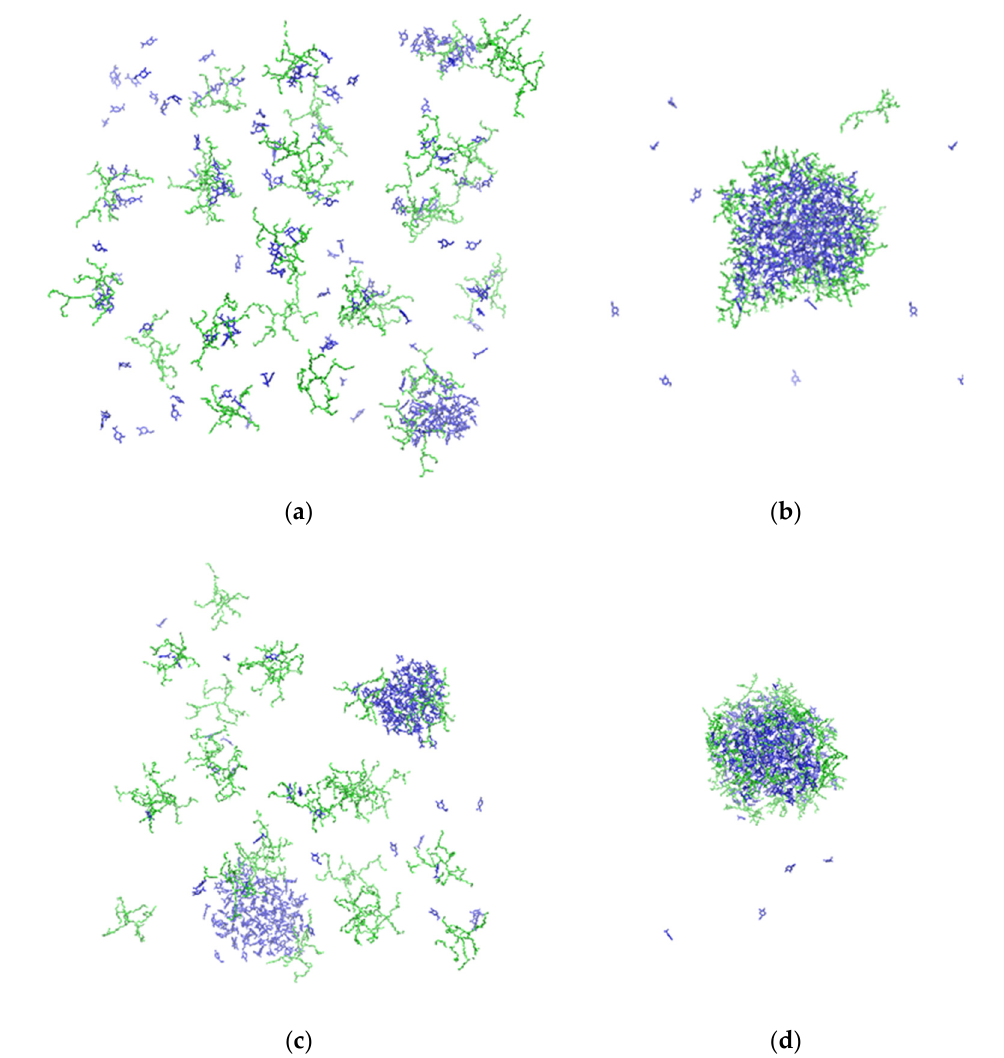
Figure 3. Final configurations of 27-polymer chain systems with carvacrol or four-ingredient essential oil mixtures. The numbers in parentheses denote the relative molar proportions: ( a ) HBPEI–carvacrol (1:7); ( b ) HPG–carvacrol (1:10); ( c ) HBPEI–carvacrol–p-cymene– γ -terpinene–thymol (27:189:18:15:7); ( d ) HPG–carvacrol–p-cymene– γ -terpinene–thymol (27:270:26:22:10); green: polymer; blue: essential oil molecules. Water molecules are omitted for clarity.